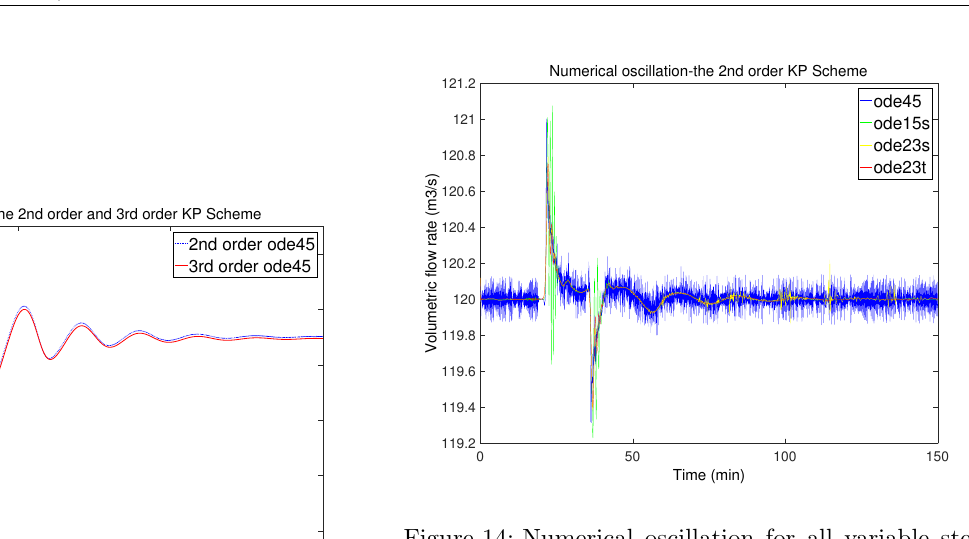
Figure 14: Numerical oscillation for all variable step- length solvers for 2 nd and 3 rd order KP scheme (Dissanayake et al.,